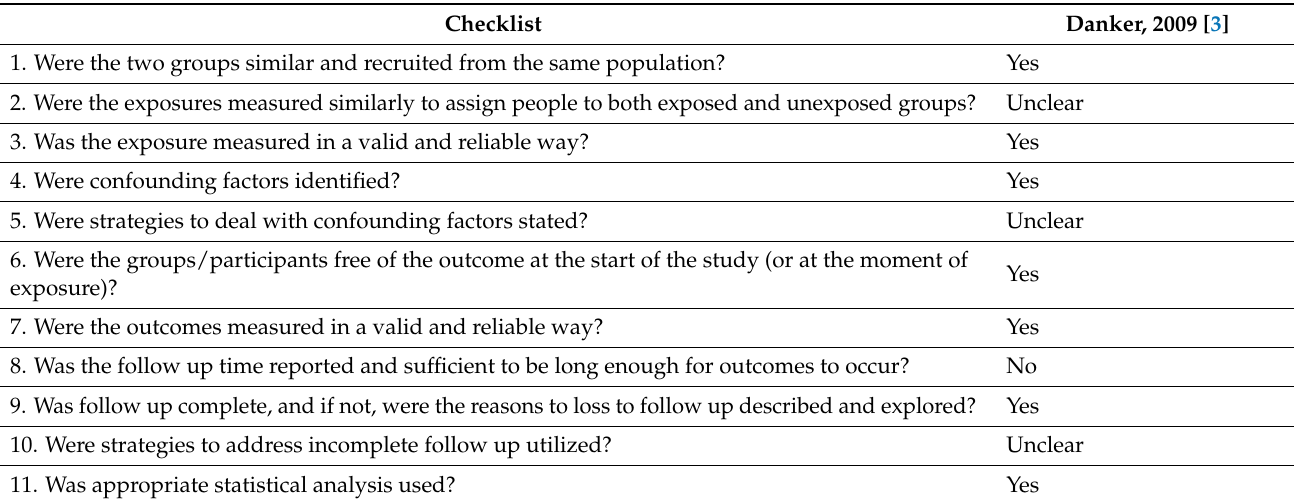
Table 1. JBI bias appraisal tool for cohort